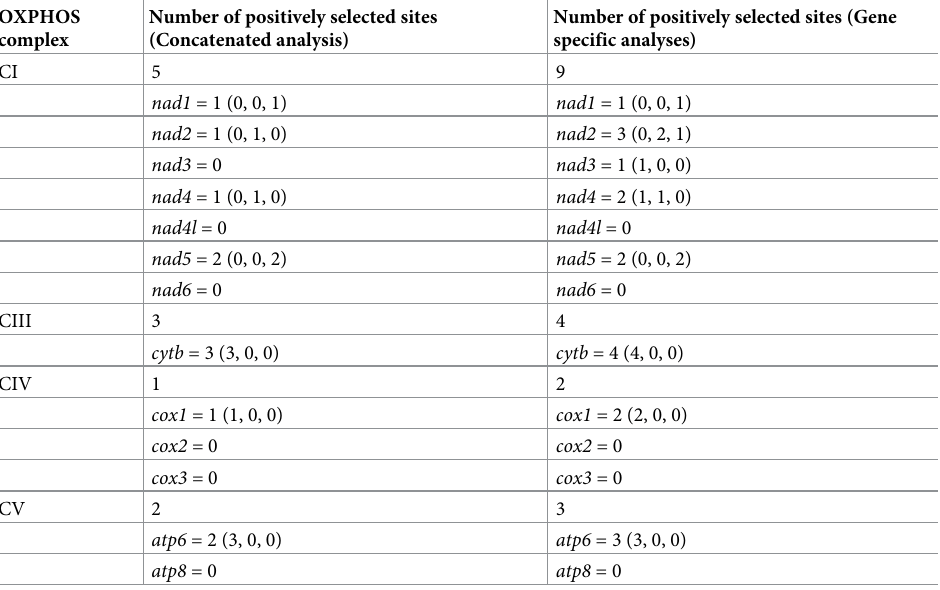
Table 3. The distribution of positively selected sites among genes and OXPHOS complexes in branch-site model. OXPHOS Number of positively selected sites complex (Concatenated analysis)